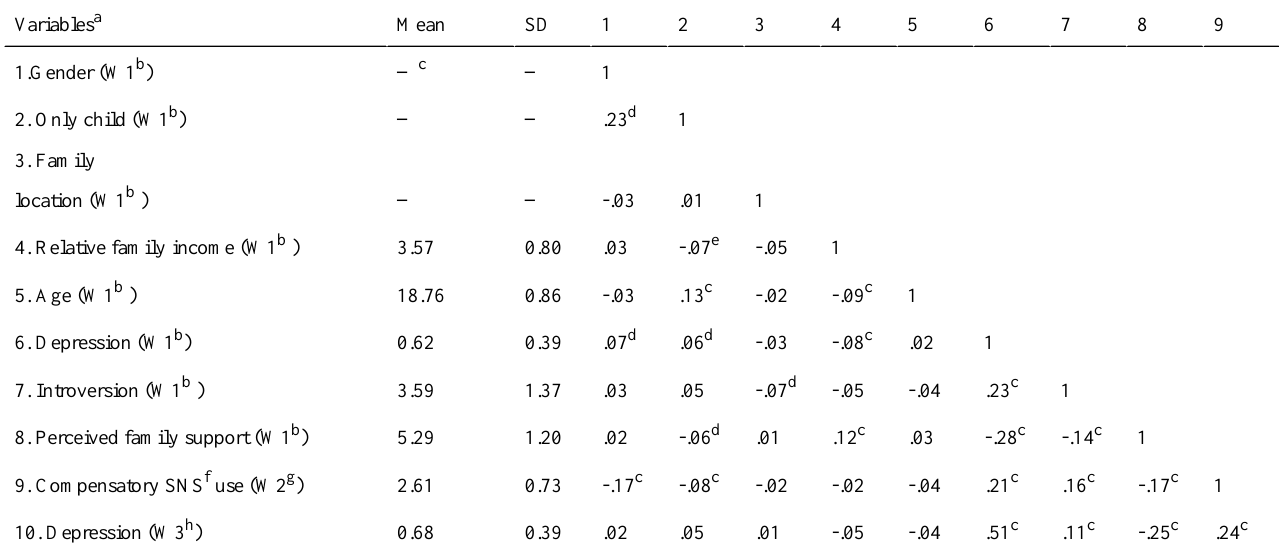
Table 1. Descriptive statistics